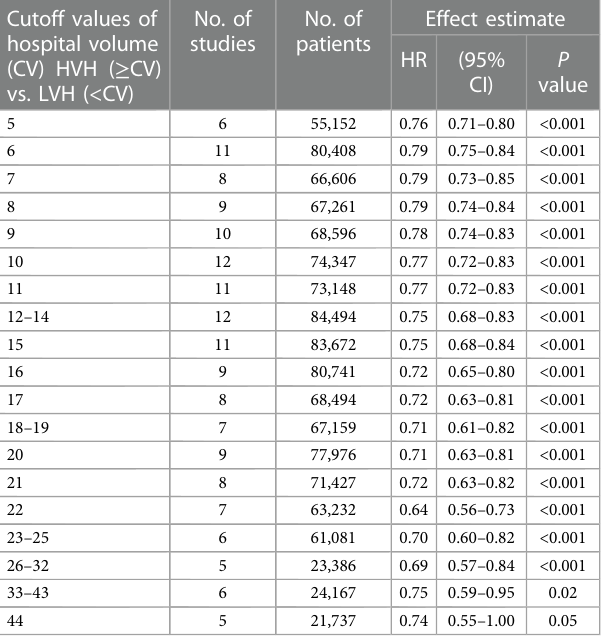
TABLE 3 Comparisons of the overall survivals between high- and low- volume hospitals by different cutoff values of hospital volume. Cutoff values of hospital volume